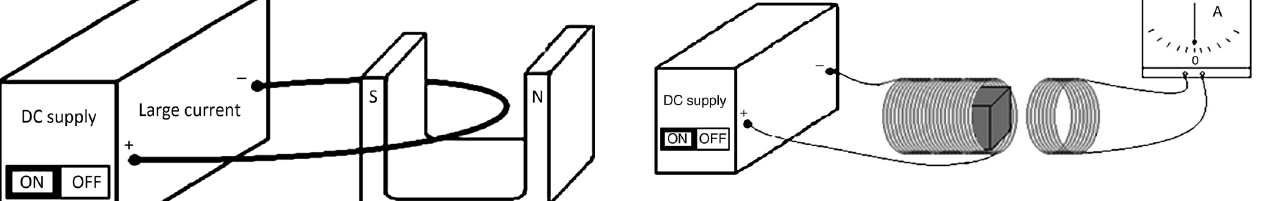
FIG. 5. Experiment 5: demonstrating electromagnetic induction using two coils. Primary coil with an iron core was connected to a dc supply and a secondary coil, with less windings than the primary, to the galvanometer. At first, the coils were positioned parallel to each other, and the current in the large coil was switched on and, after some time, off. The same was repeated for perpendicularly oriented coils and for coils at about 45 degrees to each other.